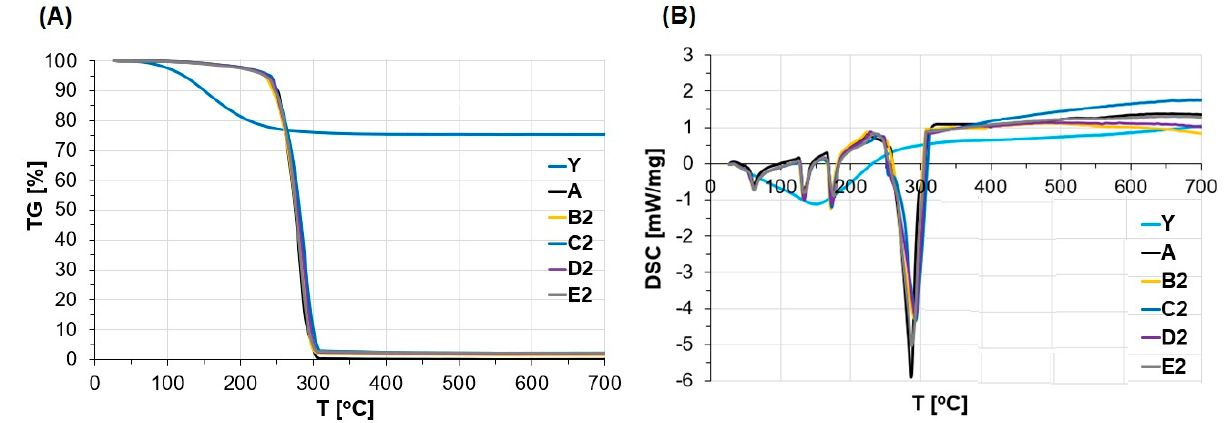
Figure 6. ( A ) TG and ( B ) DSC analysis of the ANFO samples.